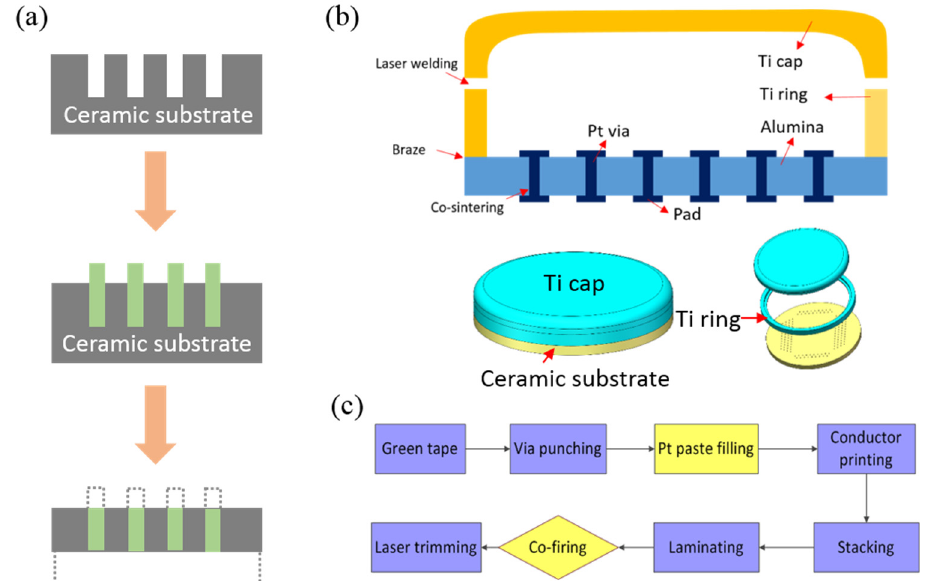
Figure 2. ( a ) Illustration of the package fabrication process described by a patent from Second Sight; ( b ) the cross-sectional (top) and 3D illustration (bottom) of implantable body for retinal implant with 100+ channel, and ( c ) the major process flow for platinum/alumina composite substrate in our group.